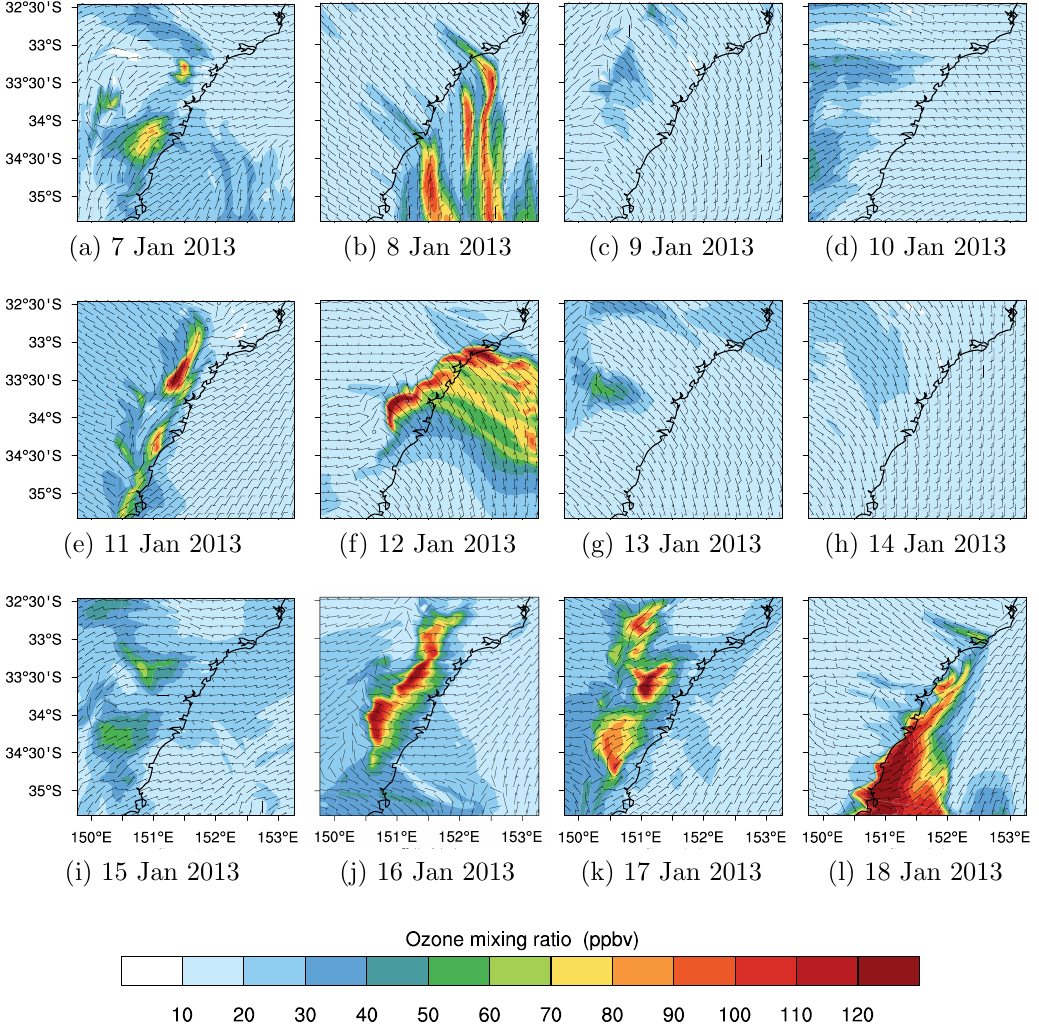
Figure 7. Simulated surface O 3 from 7 January to 18 January 2013 at 3:00 p.m. local